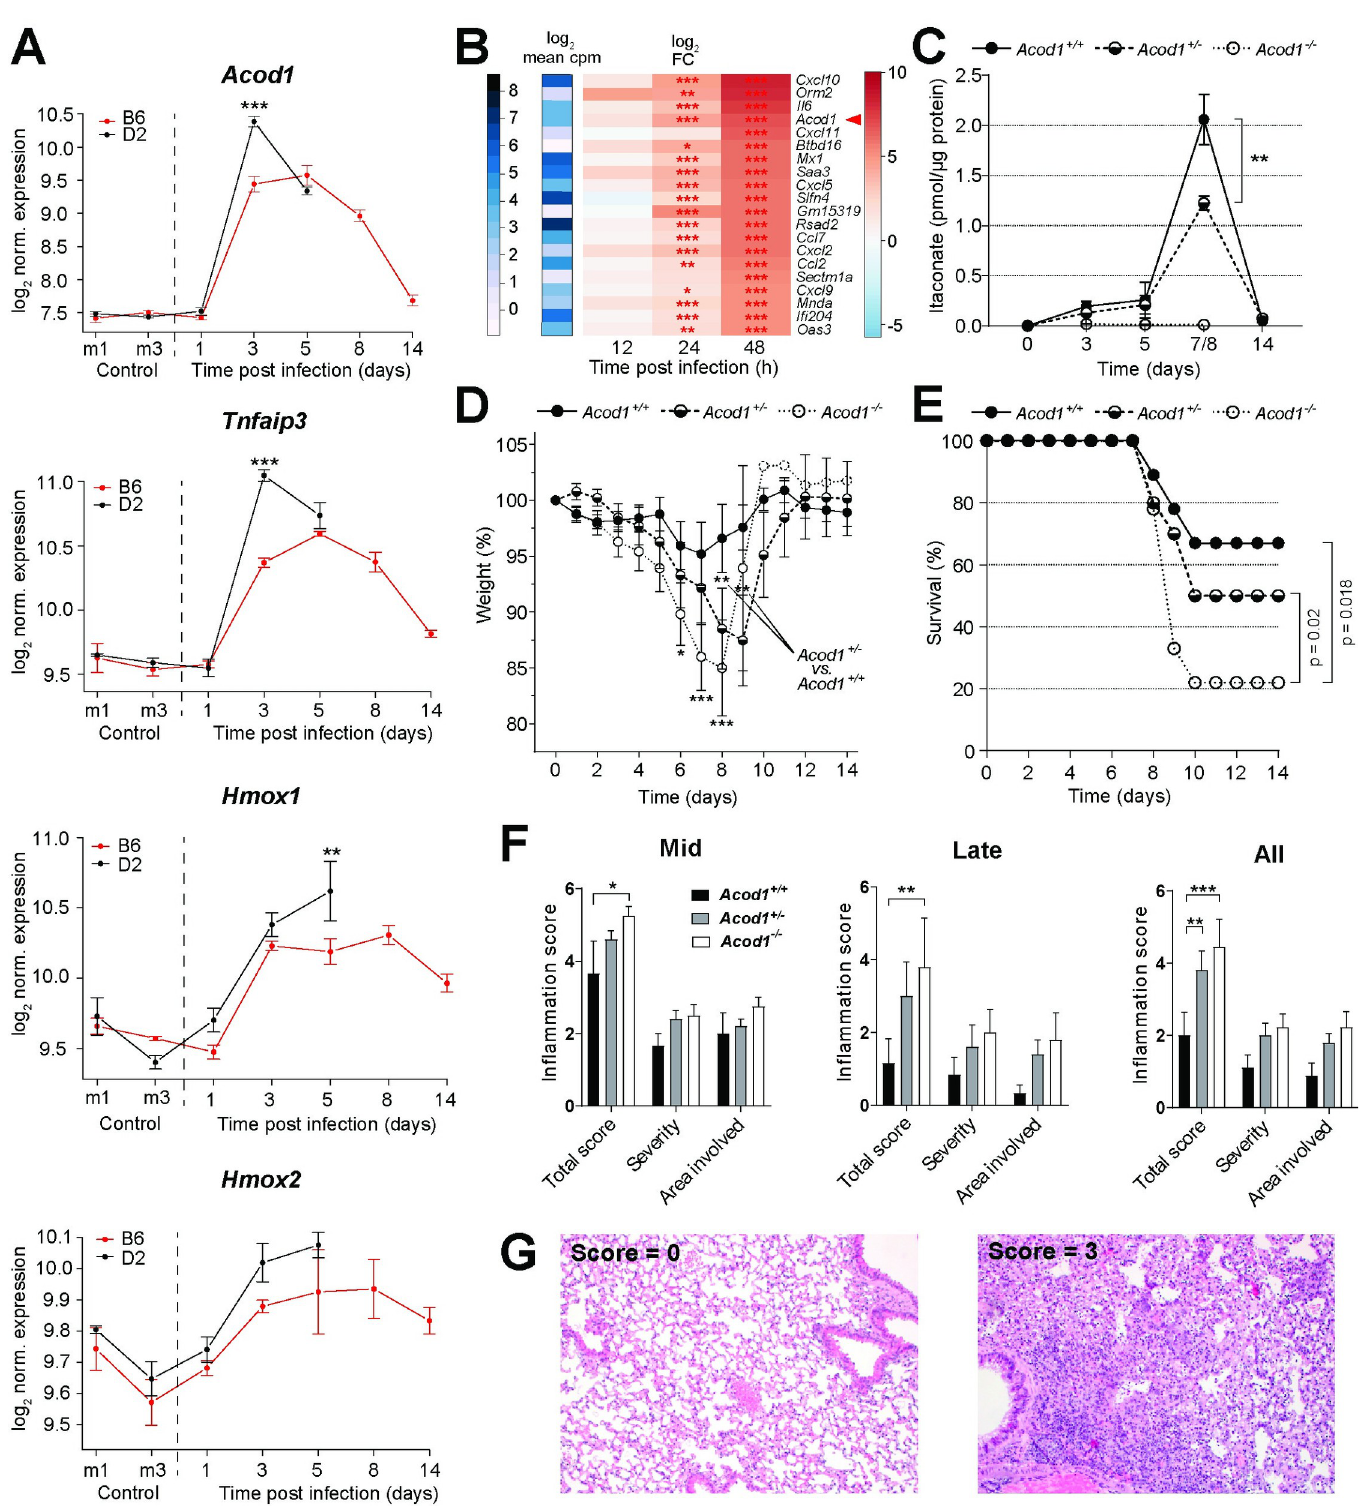
Fig 1. Reciprocal interactions between Acod1 expression and inflammation during influenza A virus infection in mice. A. Higher pulmonary expression of Acod1 , Tnfaip3 , and Hmox1 and 2 mRNA in DBA/2J (D2) than in C57BL/6J (B6) mice following IAV infection (2x10 3 FFU PR8M; reanalysis of published RNAseq data [31])